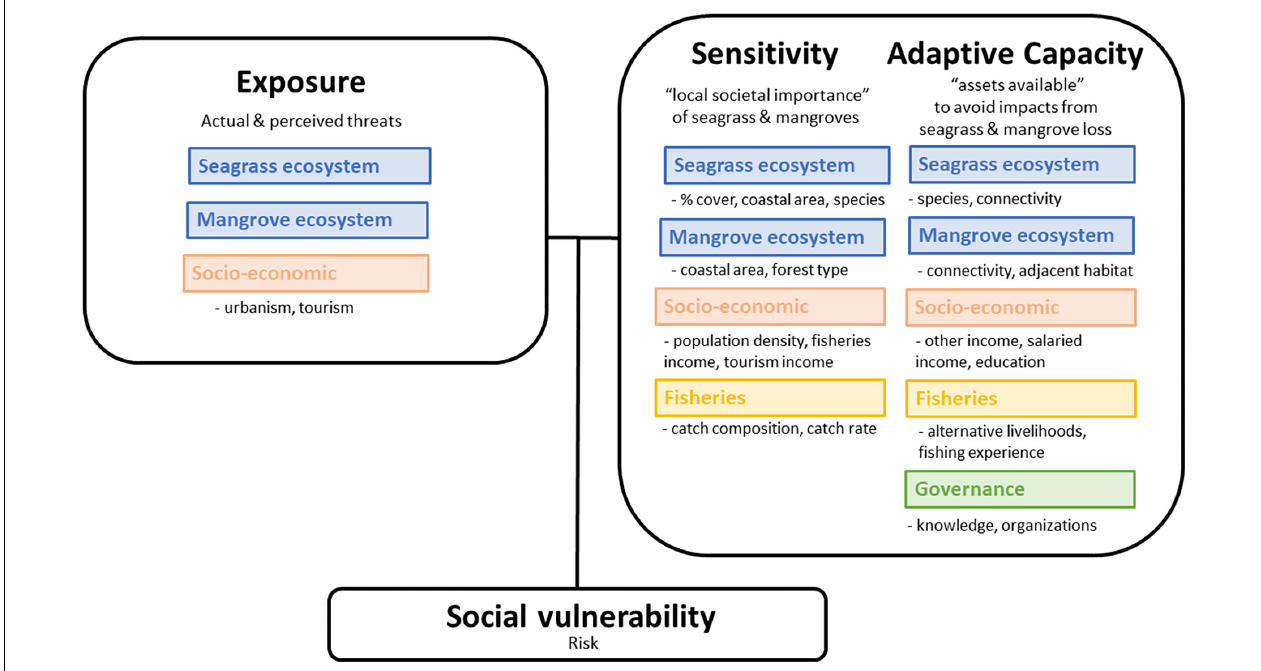
FIGURE 1 | Conceptual diagram of the vulnerability framework. Exposure are the actual and perceived threats to the seagrass and mangrove ecosystems and exposure due to socio-economic context. Sensitivity is the community’s present ability to respond to the threat, or the “local societal importance” of seagrass and mangroves. Adaptive capacity is the ability of communities to change in the face of current and future threats, or the “assets available” to avoid impacts from threats. Adapted from Cutter et al. (2008) and Ekstrom et al. (2015). All three contribute to overall risk, or social vulnerability.